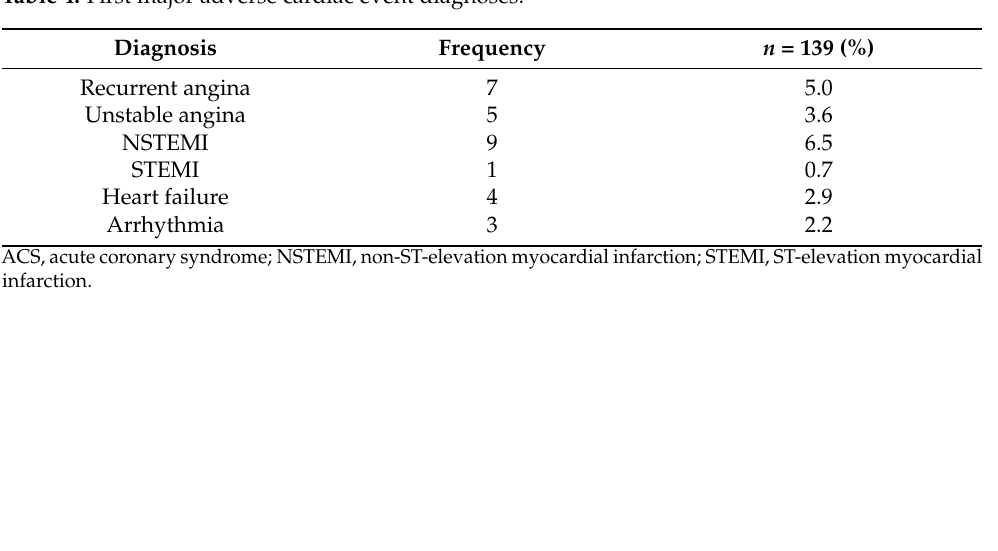
Table 4. First major adverse cardiac event